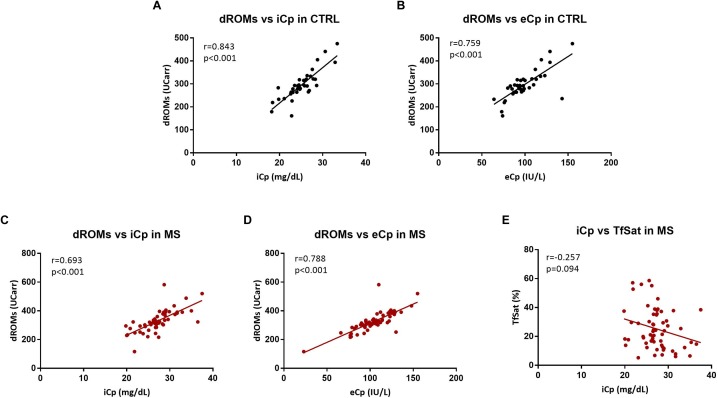
(A,B) Correlation between hydroperoxides (dROMs) and ceruloplasmin (iCp and eCp, respectively) in CTRL. (C,D) Correlation between hydroperoxides (dROMs) and ceruloplasmin (iCp and eCp, respectively) in MS. (E) Correlation between ceruloplasmin (iCp) vs. transferrin saturation (TfSat %) in MS. A p-value < 0.05 was considered statistically significant.